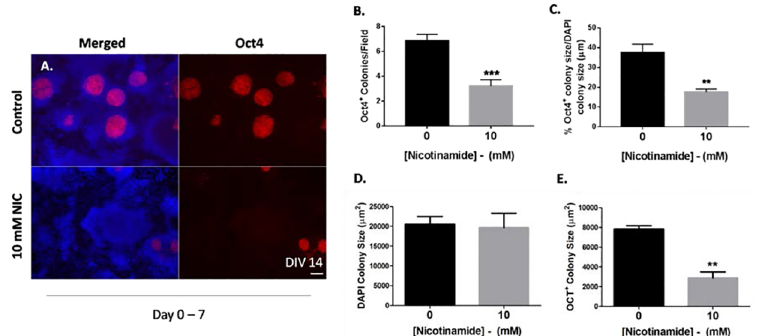
Fig 3. Early nicotinamide treatment acceleratesstem cell differentiation. (A-B)Nicotinamide-treated cultures (10 mM added from day 0–7) exhibitedsignificantly lower numbersof Oct4 + coloniesat day 14. (C) Oct4 + colonieswere smaller in area within DAPI + coloniesin cultures treated with nicotinamide. (D) DAPI colonieswere similar in area ( μ m 2 ) across all treatment conditions. (E) Areas of Oct4 + colonieswere markedly reducedin cultures treated with 10 mM nicotinamide, suggestive of accelerated stem cell differentiation. Scale bar 100 μ m appliesto all low magnification images. ** p < 0.01; *** p < 0.001.